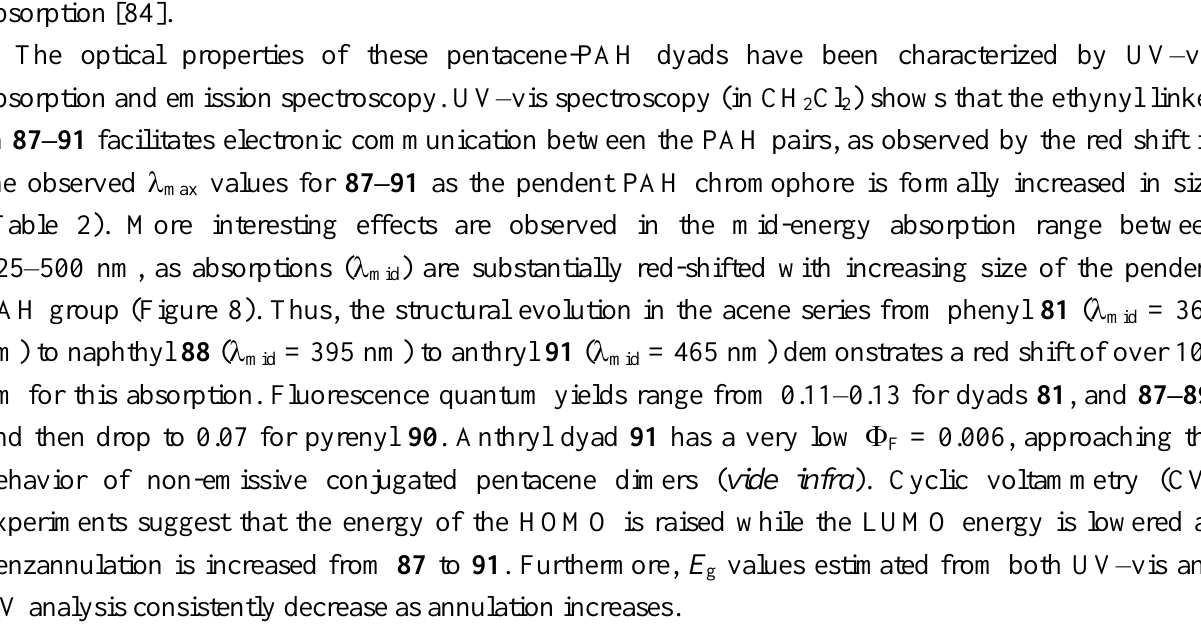
Figure 8. UV–vis absorption spectra of pentacenes 81 and 87–91 in CH